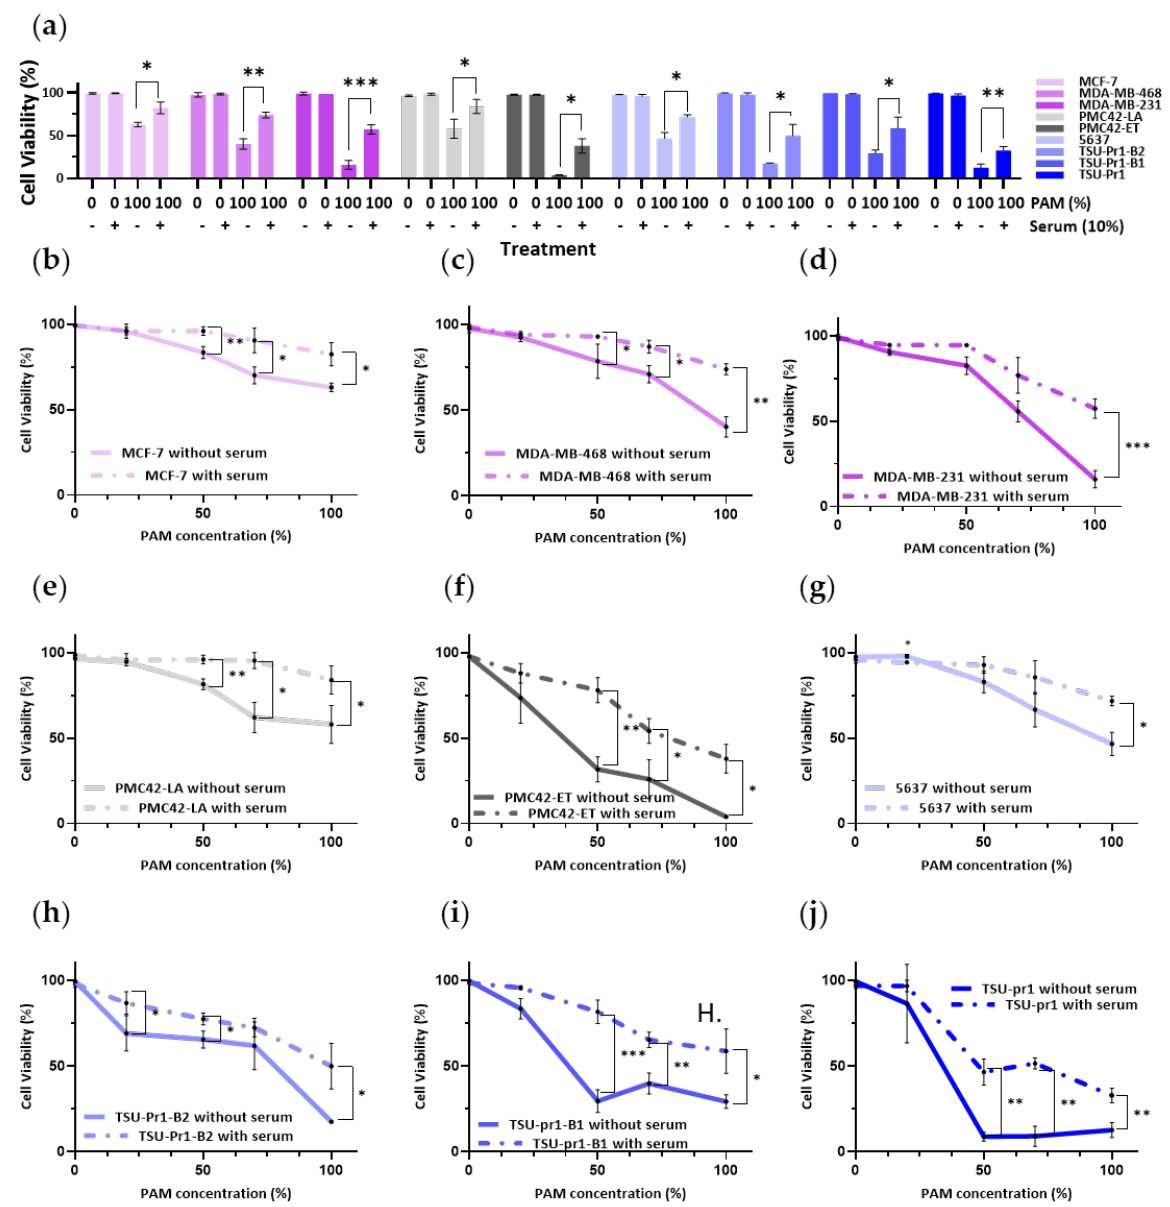
Figure 4. Impact of serum on PAM effect on cell viability. ( a ) Breast cancer cell lines (MDA-MB-231/MDA-MB-468/MCF-7; pink) and EMT/MET cell line systems in breast (PMC42-ET/LA; grey) and bladder (5673/TSU-Pr1/B1/B2; blue) cancer cells were plated in growth media for 24 h prior to 3 h serum starvation. Cells were then treated with 0% or 100% 10PAM in the absence or presence of FBS (10%) for another 12 h. After the treatment, these cells were stained with DAPI for DNA and PI for apoptosis assessment, and the cell viability was calculated by live/dead cell assay. MCF-7 ( b ), MDA-MB-468 ( c ), MDA-MB-231 ( d ), PMC42-LA ( e ), PMC42-ET ( f ), 5637 ( g ), TSU-Pr1-B2 ( h ), TSU-Pr1-B1 ( i ), and TSU-Pr1 ( j ) cells were plated as per ( a ) and treated with 0%, 25%, 50%, 75%, and 100% 10PAM for 12 h in the absence or presence of FBS (10%). The cell viability was tested as per ( a ); dotted lines represent plus serum. The mean and SEM of the average for each data point from each of the 3 experiments are shown. “*” represents a p < 0.05, “**” represents a p < 0.01, and “***” represents a p < 0.001